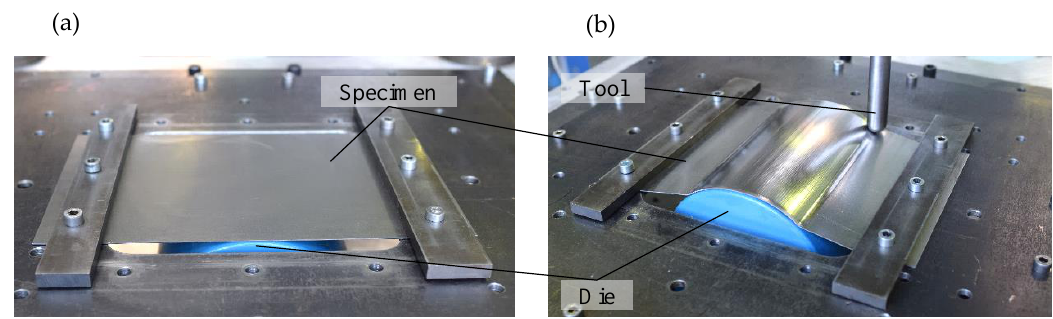
Figure 4. Experimental setup before forming ( a ) and after stretch forming and ISF ( b ).